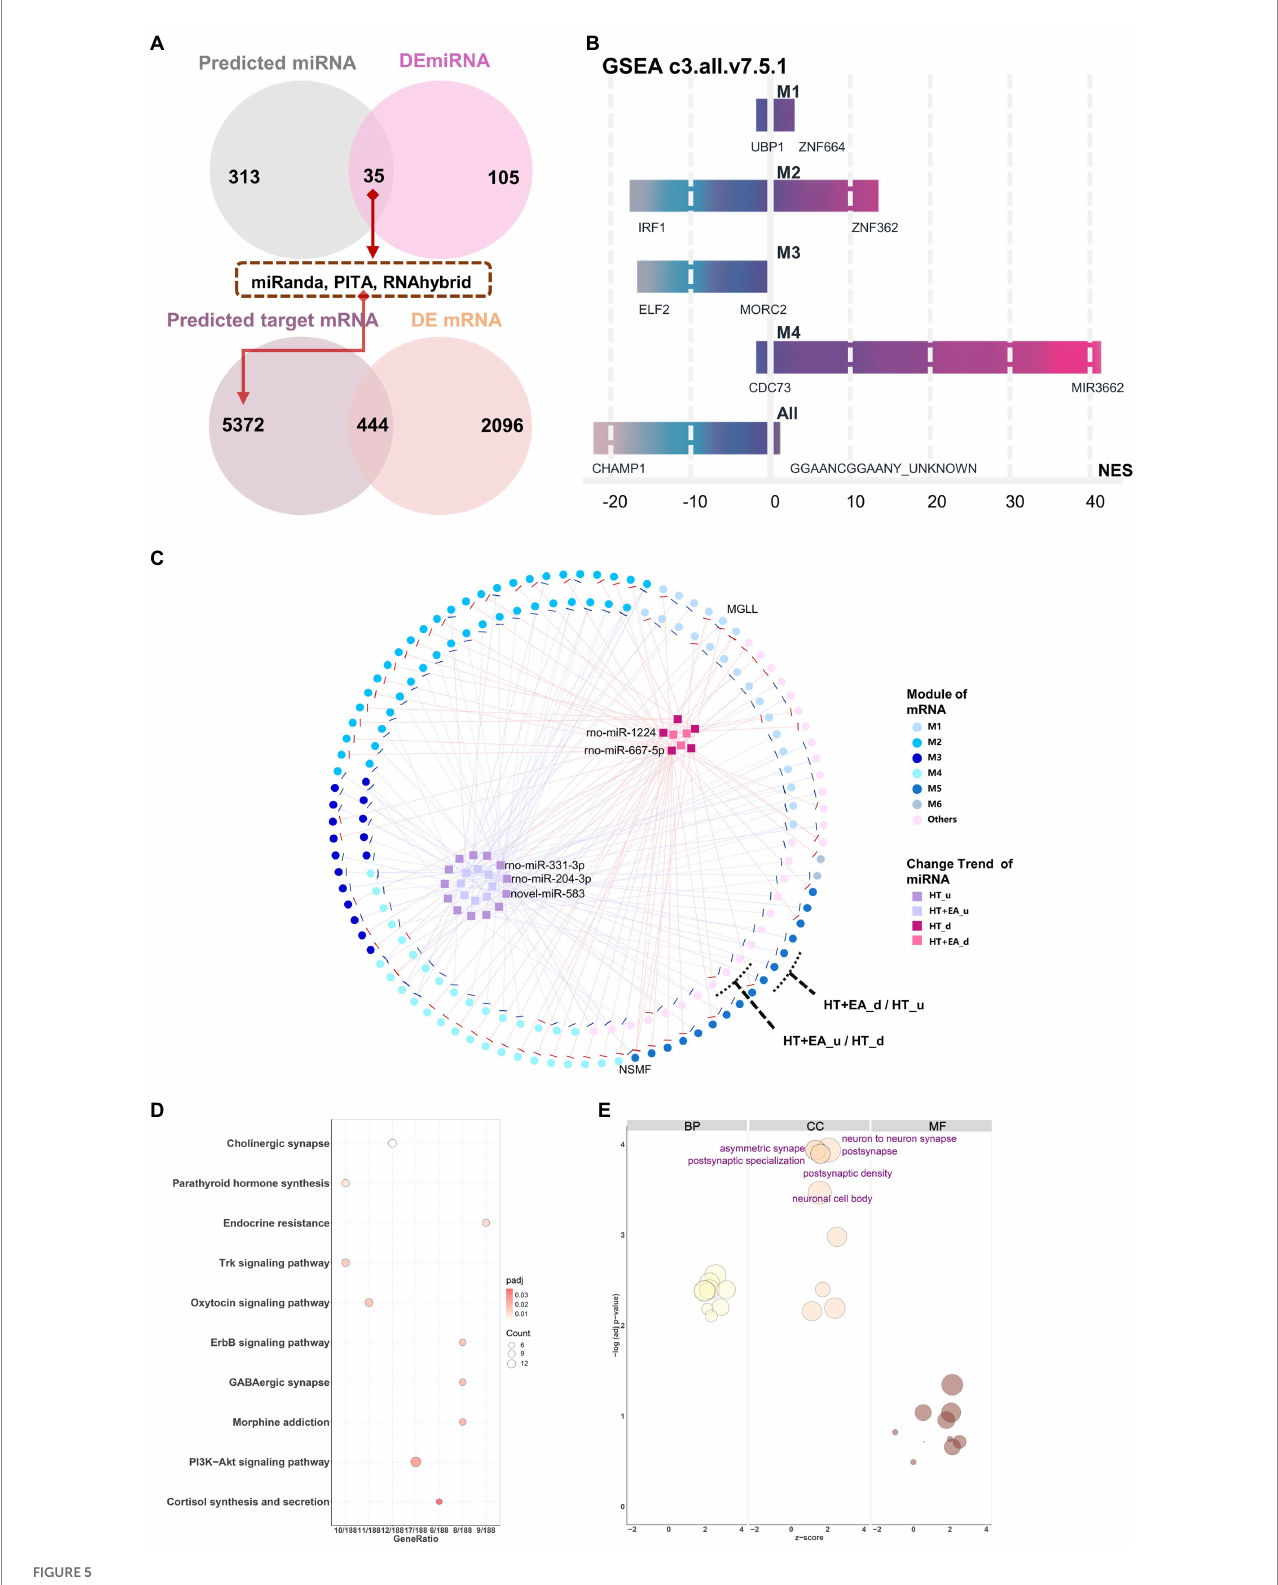
FIGURE 5 Interaction networks of nmiRNAs and functional enrichment analysis. (A) The data flow shows the overlaps for filtering out the nmiRNAs and the targeted genes. (B) Potential gene target prediction for six modules using the GSEA curated gene set C3 database (Molecular Signatures Database v7.5.1). M5 and M6 were omitted because of the small number of genes in the sets. (C) Interaction networks showed miRNAs with different change trends distributed among the six gene modules, including HT up-or down-regulated (HTu and HTd) and EA up-or down-regulated (EAu, EAd). The top 5 weighted miRNAs were labelled based on their degree of connection with mRNA. (D,E) KEGG and GO functional enrichment analysis of miRNA-targeted